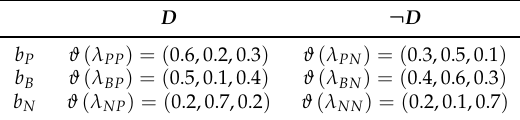
Table 11. The loss function 3 matrix.